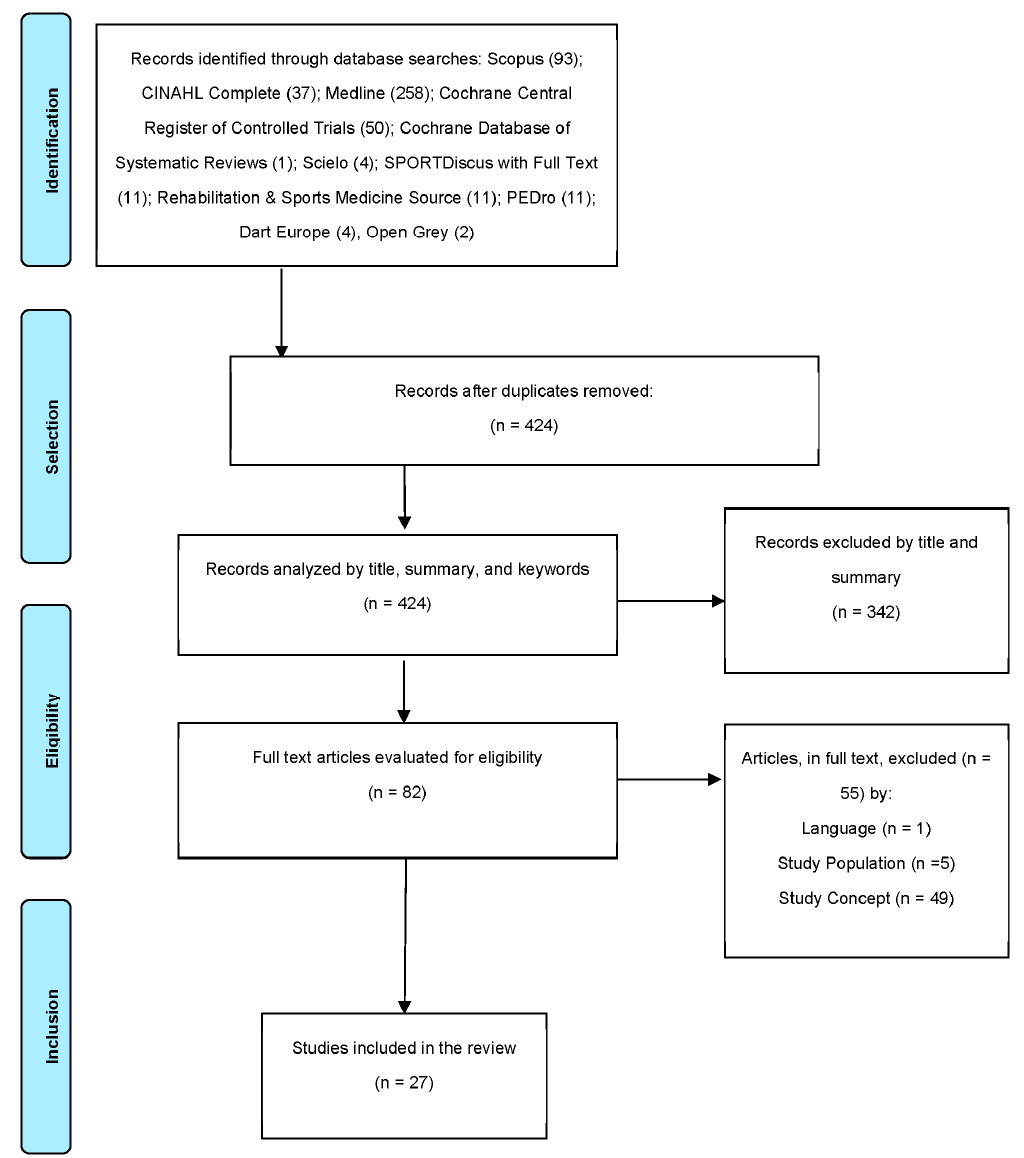
Figure 1. PRISMA flow diagram of the systematic review process.